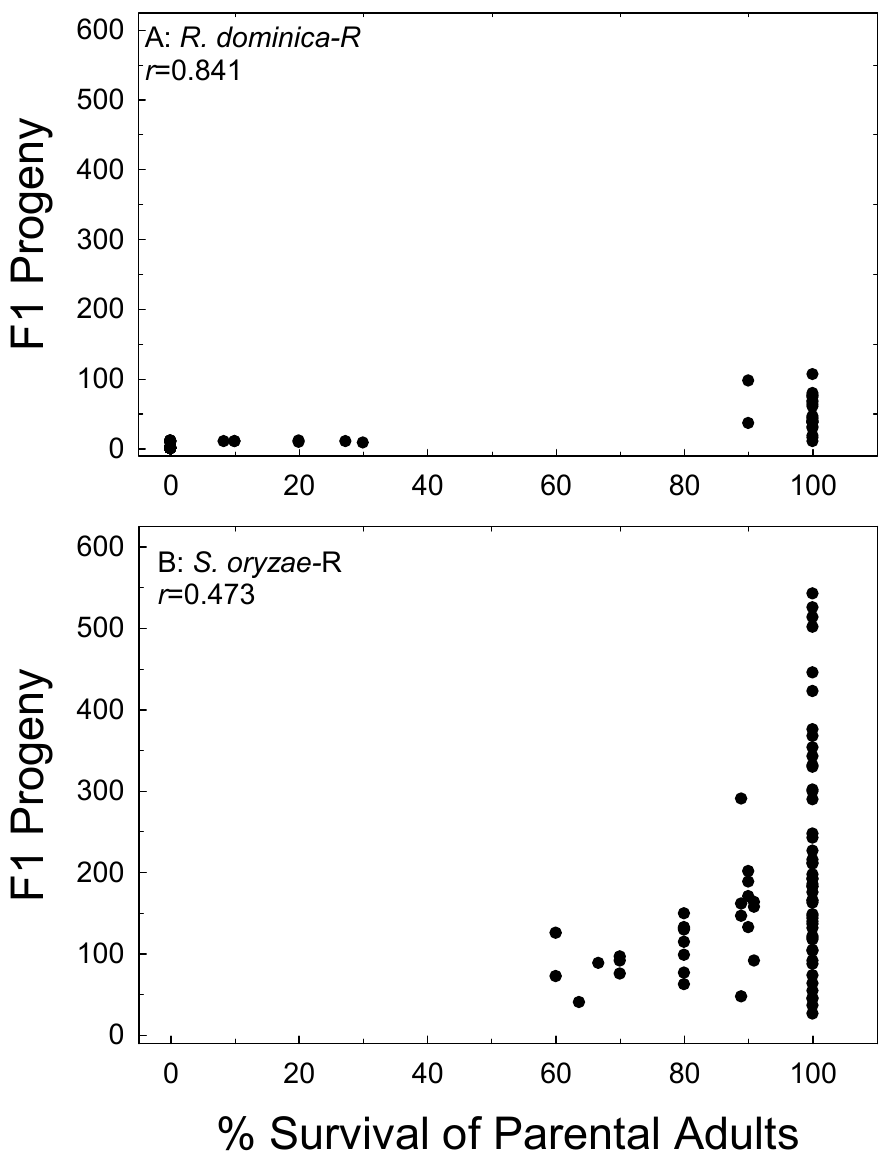
Figure 7. Correlation of parental survival with F 1 progeny production of R. dominica ( A ) and S. oryzae ( B ) on brown rice (R). Data combined for all treatments and all bioassay months.